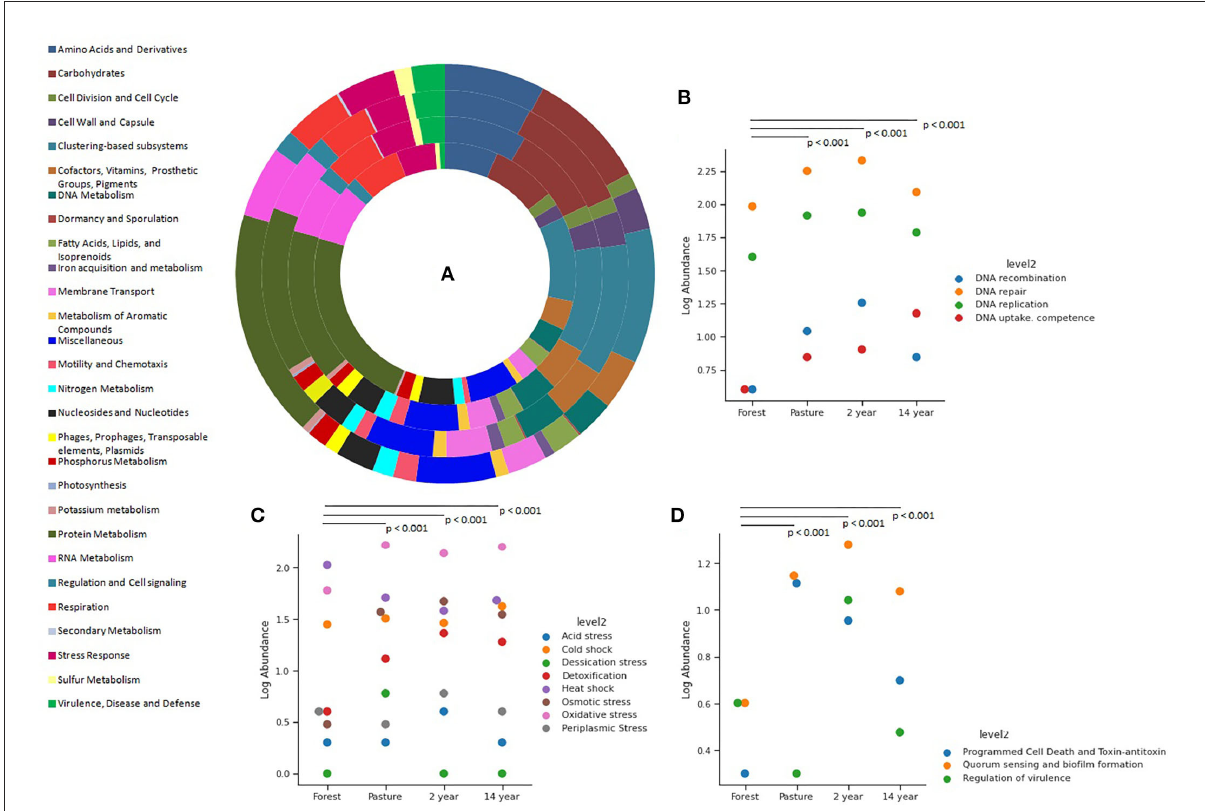
FIGURE2 Distribution of the functional classes of genes from different soils, identified from the SEED Subsystem database: (A) First level of genes: from the inside out is the forest, pasture, 2-years, and 14-years soybean sites. The classification at the second level of the genes of (B) DNA metabolism, (C) stress response, and (D) cell regulation and